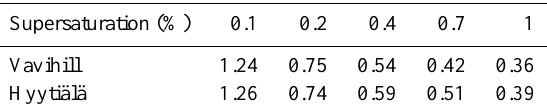
Table 3. Ratios between cloud condensation nuclei measured by CCN counter for different supersaturation and N 130 measured by